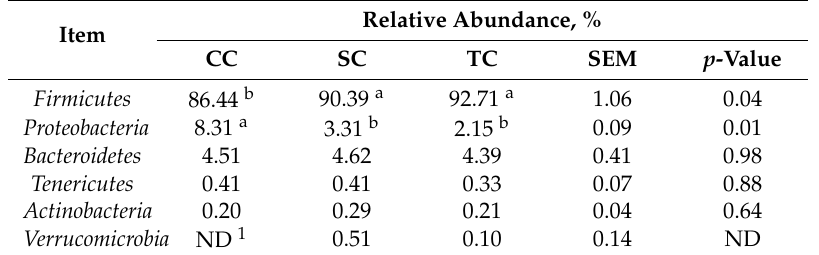
0.20 Verrucomicrobia ND 1 0.51 0.10 0.14 ND a,b Di ff erent superscript letters within a row indicate a significant di ff erence at p < 0.05. CC, control group; SC, 25% of soybean meal (SBM) replaced with fermented SBM (FSBM); TC, 50% of soybean meal (SBM) replaced with fermented SBM (FSBM). 1 ND not detected.